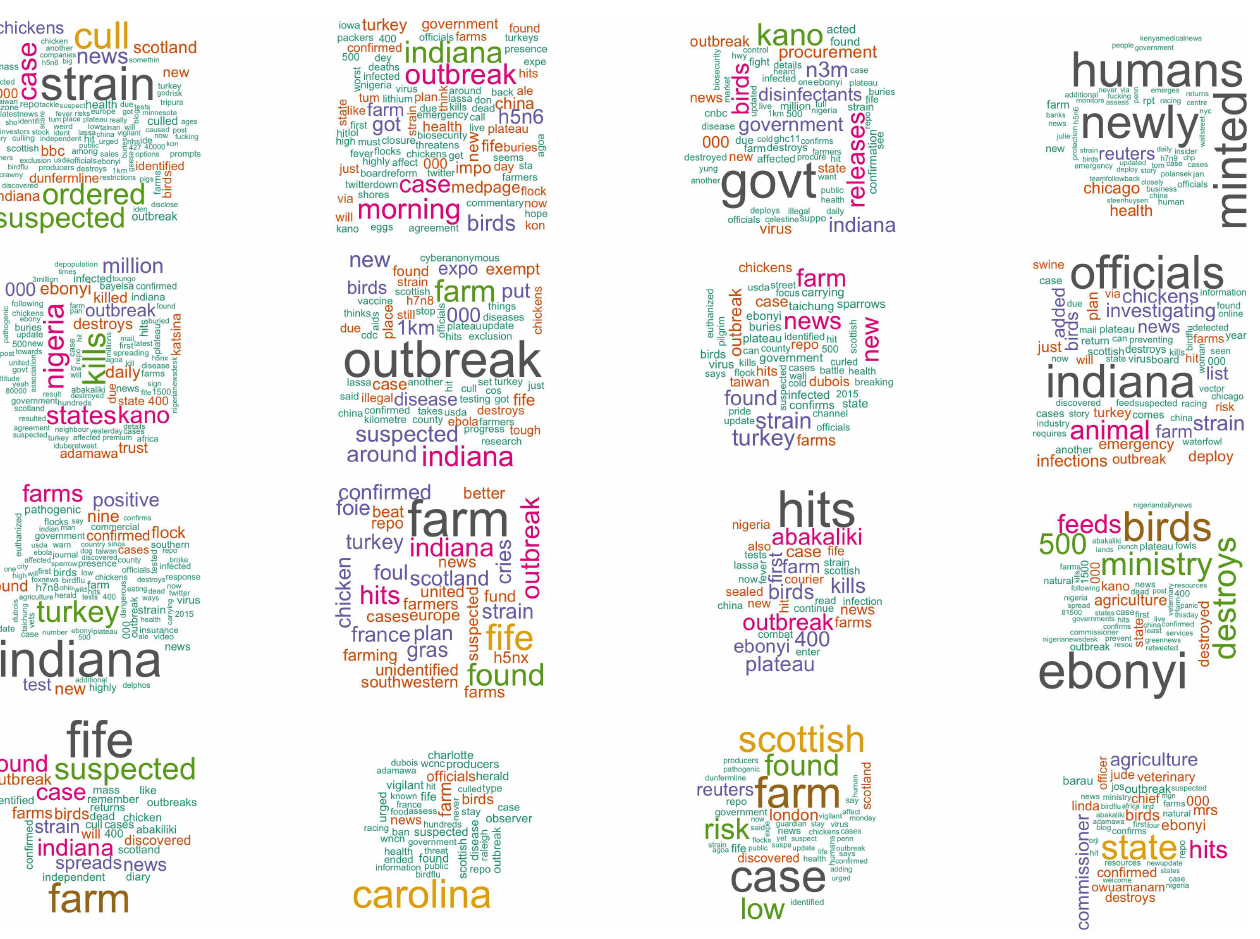
Fig 7. Wordclouds generated from original Tweets associatedwith topic models discovered from outbreaks based on the static threshold method (only 16 topics of 31 shown